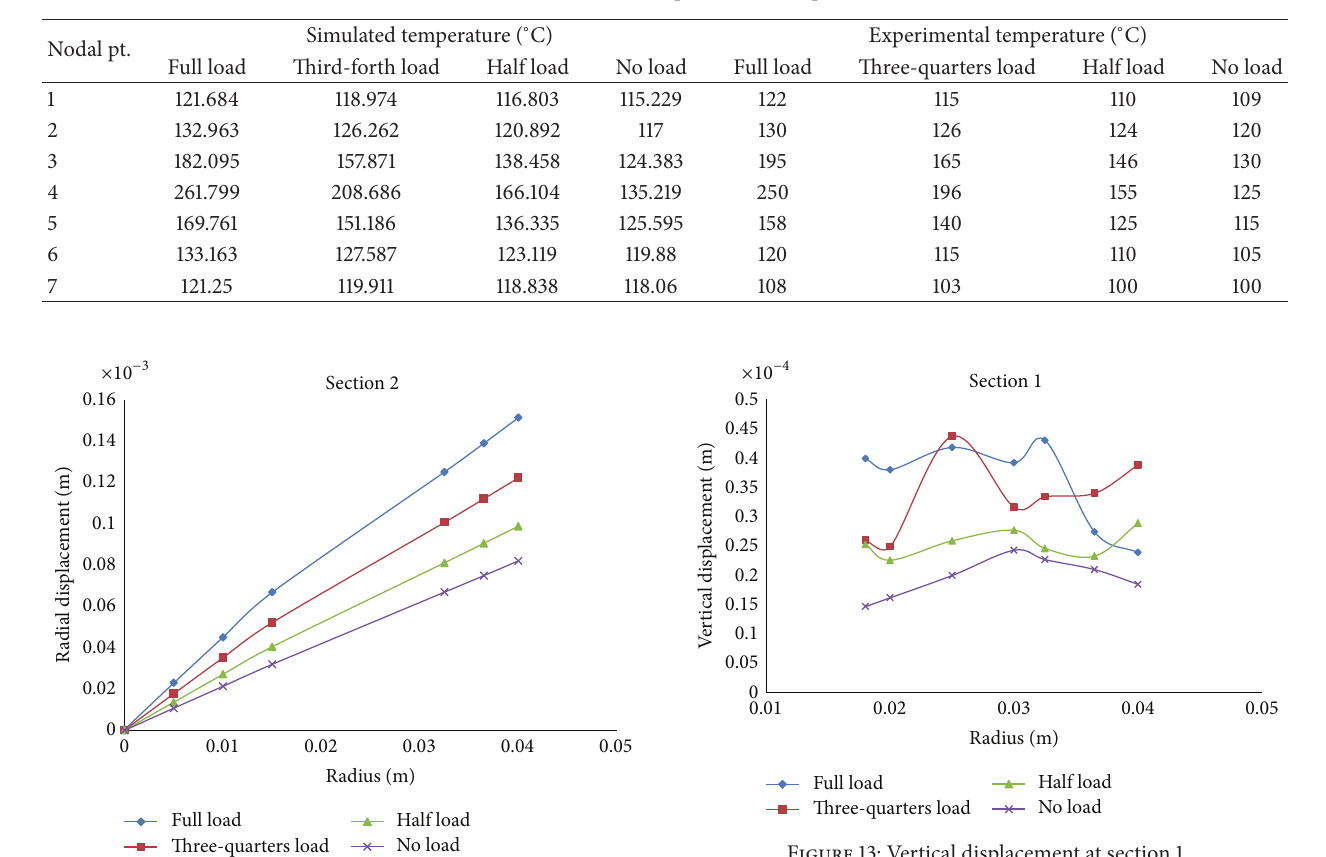
Table 5: Simulated and experimental temperature.